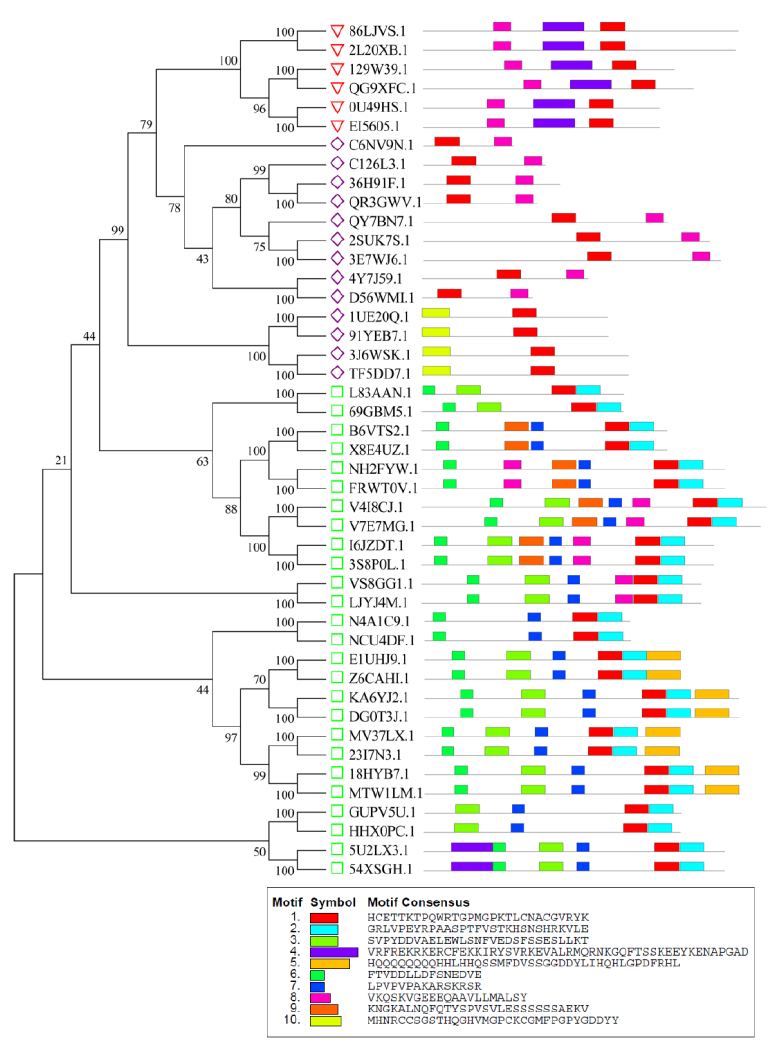
Figure 4. Conserved motifs of all identified GATA family members in A. hypogaea L.